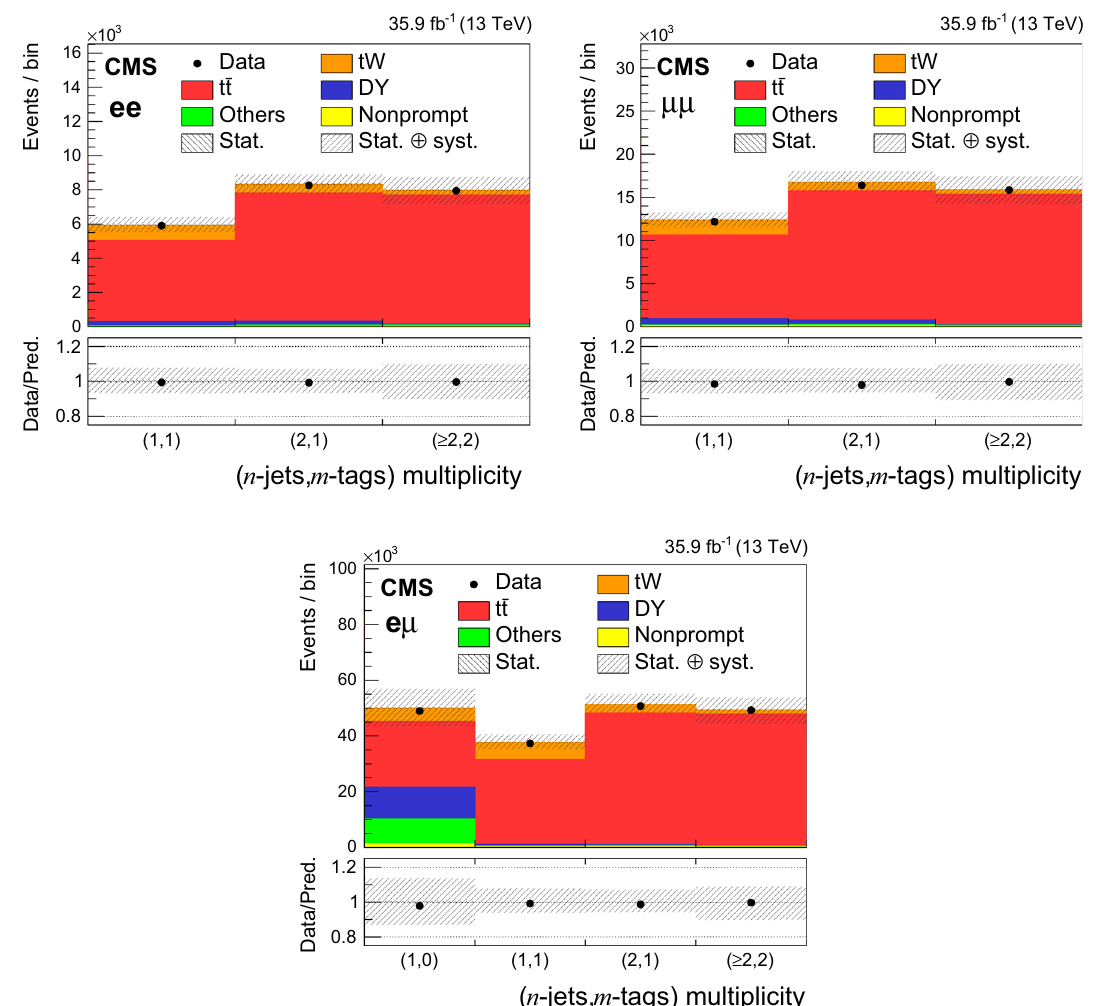
Fig. 2 TheobservednumberofeventsandSMbackgroundpredictions in the search regions of the analysis for the ee (upper left), μμ (upper right), and e μ (lower) channels. The hatched bands correspond to the quadratic sum of statistical and systematic uncertainties in the event